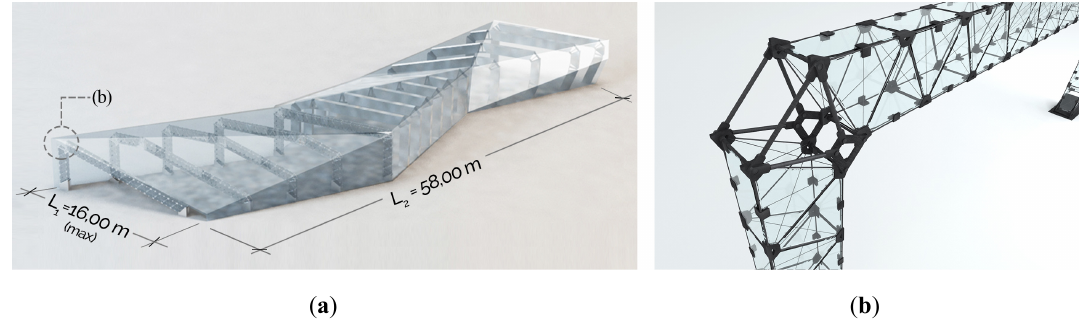
Figure 2. The Energy Gallery pilot project [29]: ( a ) overall view; ( b ) portal frame and beam-to-column connection. Main dimensions: L1 = various (16.00 m max); L2 = 58.00 m; H=various (6.50 m max).